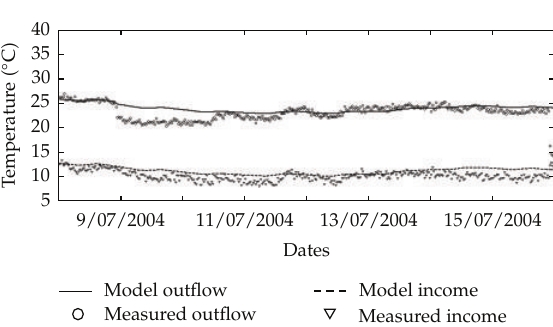
Figure 12: Comparison of the measured and modeled temperaturesin the income and outflow of the power plant with the 5th units in operation for the days between 8 and 16 July 2004.